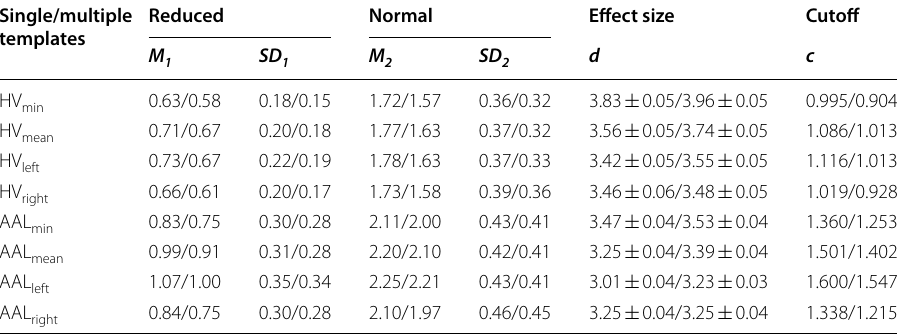
Mean values M 1 , M 2 and standard deviations SD 1 , SD 2 from the fit of the histogram of the putamen SBR by the sum of two Gaussian functions according to Eq. (1) in the whole sample, effect size d of the distance between the two Gaussian functions according to Eq. (2) (mean standard deviation from 1000 random 90% subsamples), and cutoff c for the ± dichotomization of SBR as normal or reduced according to Eq. (3) in the whole sample. The results are given separately for HV analysis and conventional semi-quantitative analysis with the anatomical AAL putamen masks, and for minimum (min) and mean SBR of both hemispheres and for left and right SBR. The results for stereotactical normalization with the single template or with multiples templates are given in each cell (single/multiple templates)